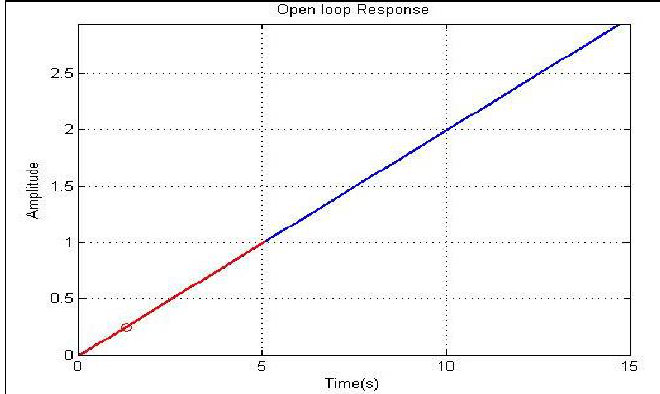
Figure 7: Open loop response model.